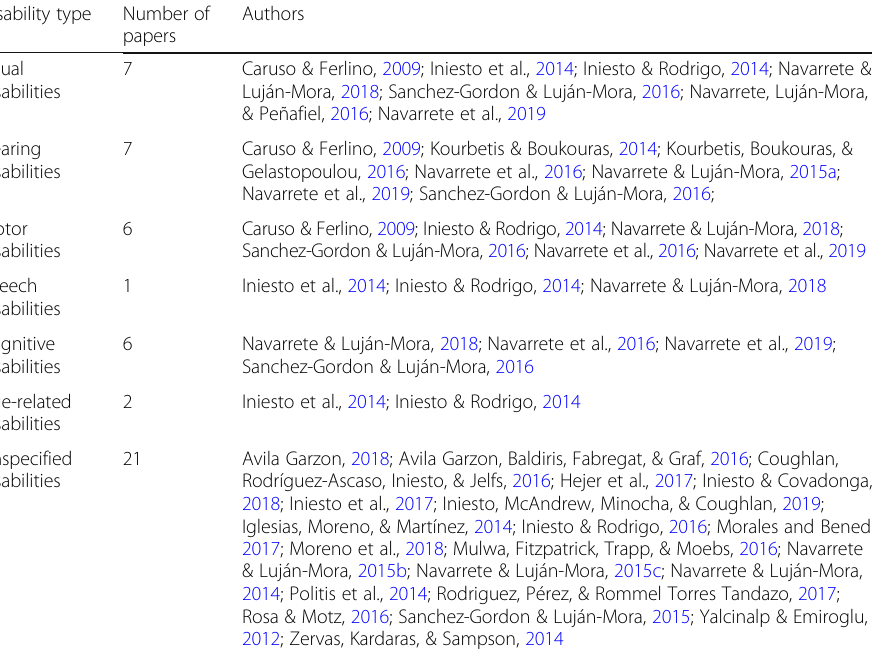
Table 3 Distribution of papers according to disability type Disability